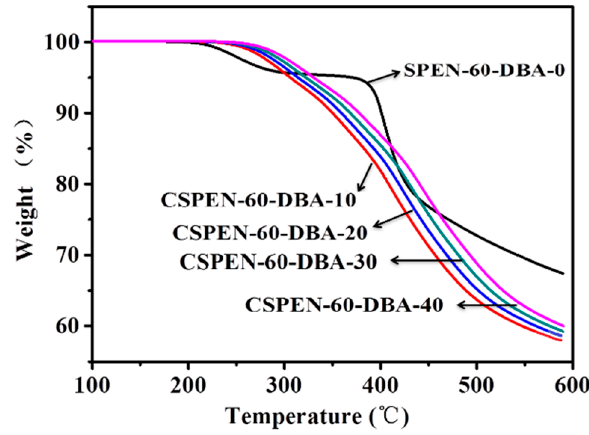
Figure 4. The thermal degradation (TGA) curve of CSPEN-60-DBA-x.